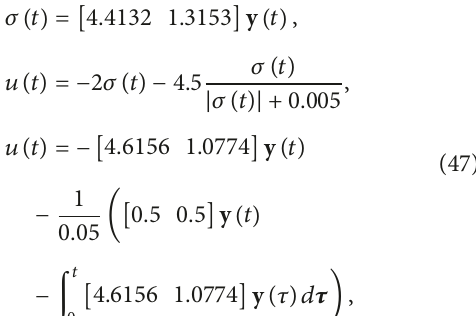
The system states are finally bounded in a small region and robust stability of the closed-loop system is guaranteed. For